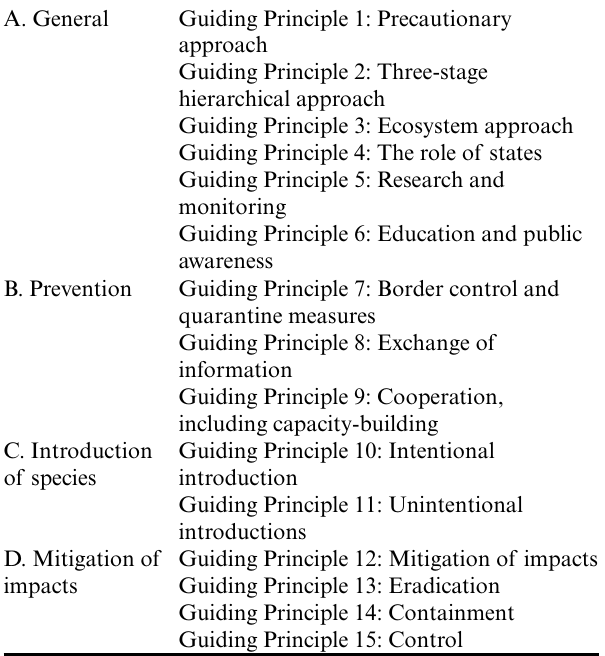
Table 1 . Guiding principles for invasion management (Source: